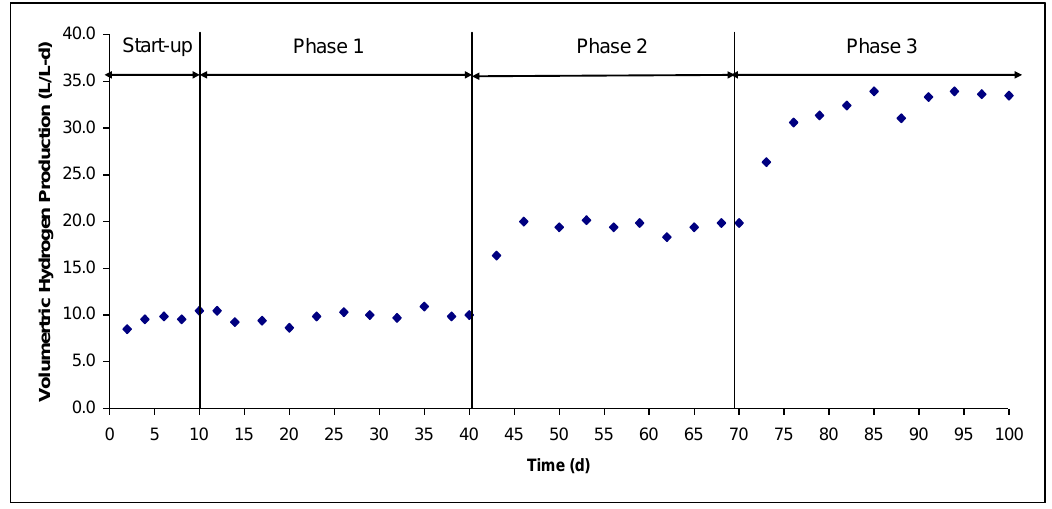
Figure 2. Temporal variation of volumetric hydrogen production rate.